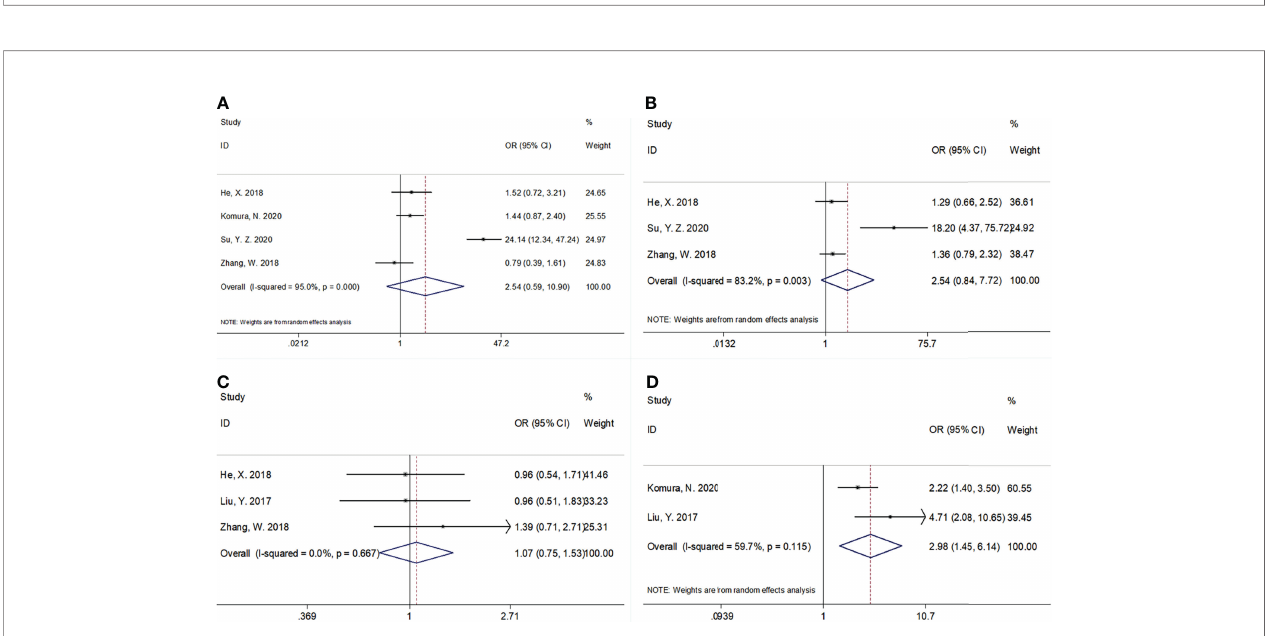
FIGURE 4 | The association between CRP/Alb ratio and clinicopathological features in patients with gynecological cancers. (A) Lymph node metastasis (yes vs. no), (B) tumor size ( ≥ 4 vs. <4 cm), (C) histological grade (G3 vs. G1/G2), and (D) FIGO stage (III – IV vs. I –